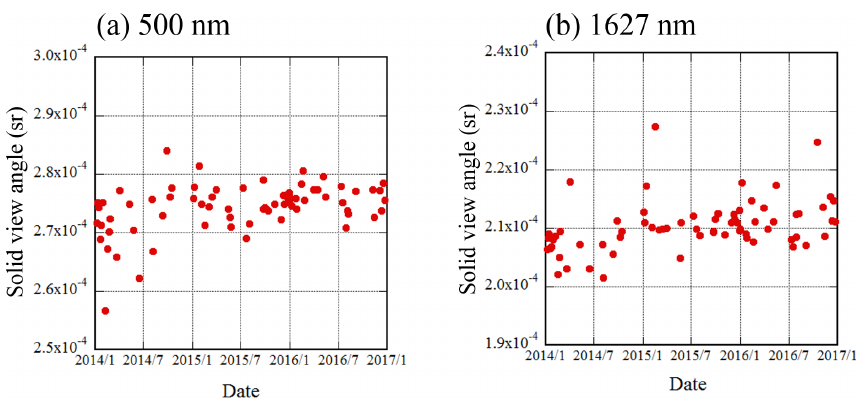
Figure 7. Time series of the SVA at POM-02 (Tsukuba) from January 2014 to December 2016. (a) 500nm, the mean and standard deviation are 2 . 743 × 10 − 4 and 4 . 2 × 10 − 6 , respectively. (b) 1627nm, the mean and standard deviation are 2 . 104 × 10 − 4 and 4 . 4 × 10 − 6 ,